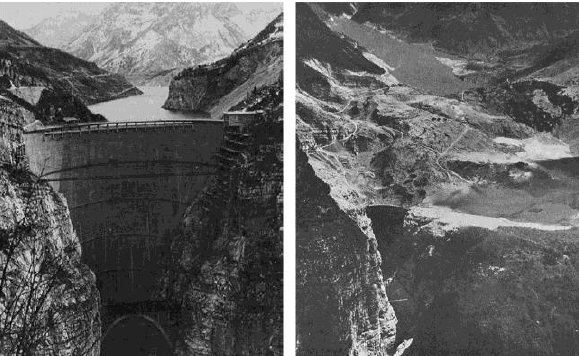
Figure 2. Vajont Dam before and after the landslide (Runout,